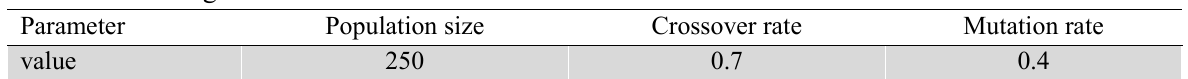
Parameter settings of GA.